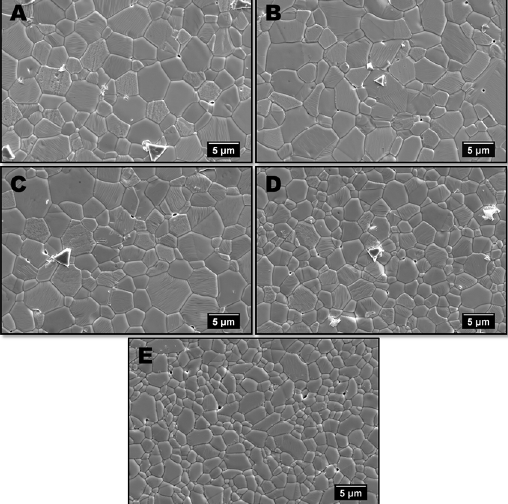
- 2 Figure 3. SE image and EDS mapping of a precipitate at the grain boundary. The cut in depth shows the three-dimensional extension of precipitate in the